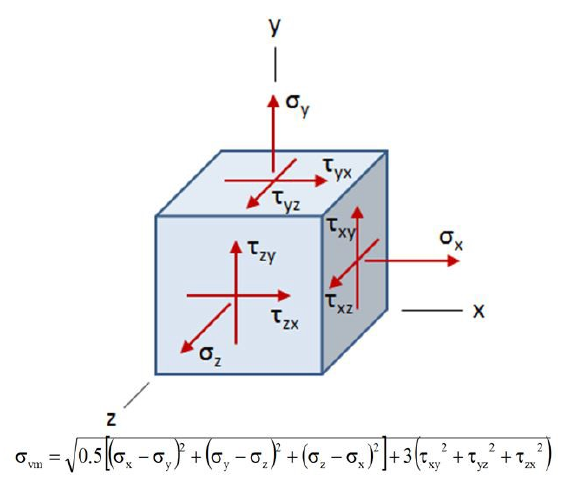
Figure 3. Von Mises stress equation expressed by the six stress components.